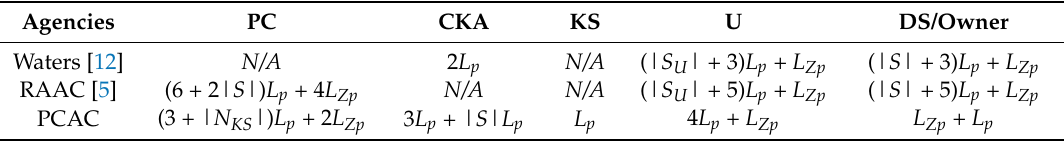
Table 1. The Storage Overhead of Our PCAC, the Waters Scheme, and the RAAC